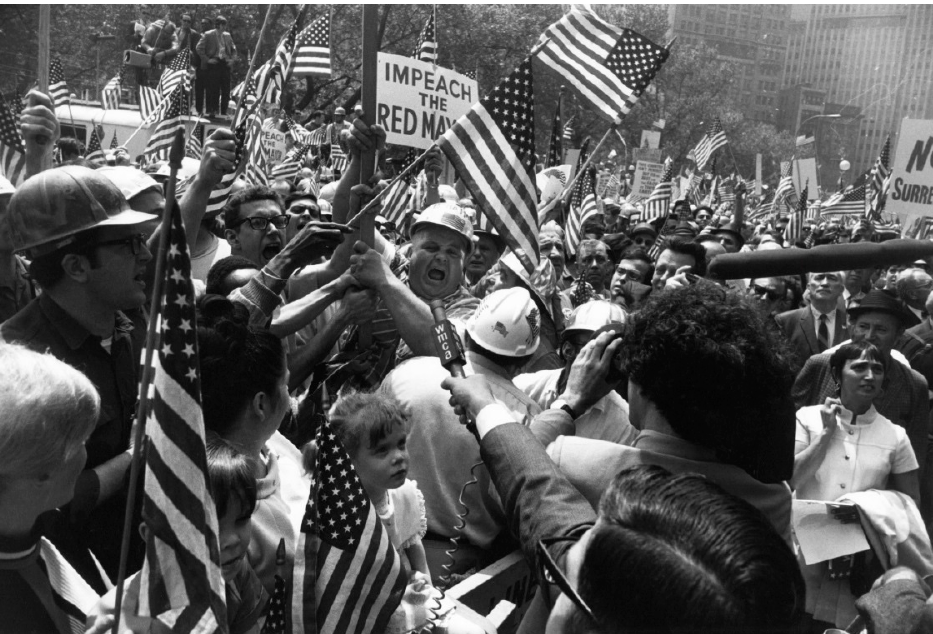
Figure 1. Garry Winogrand, New York City , 1969, Gelatin silver print, 27 × 40.4 cm, Museum of Modern Art, New York, USA. © The Estate of Garry Winogrand, courtesy Fraenkel Gallery, San Francisco.